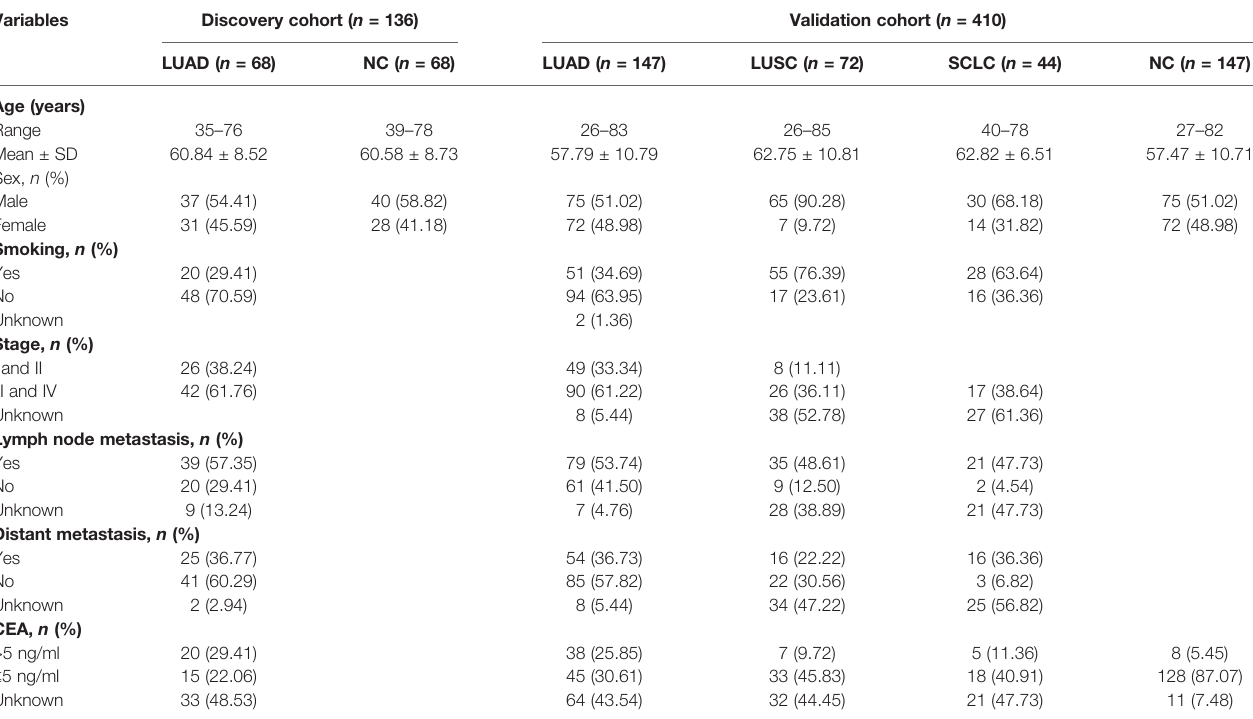
TABLE 1 | Descriptive characteristics of the study